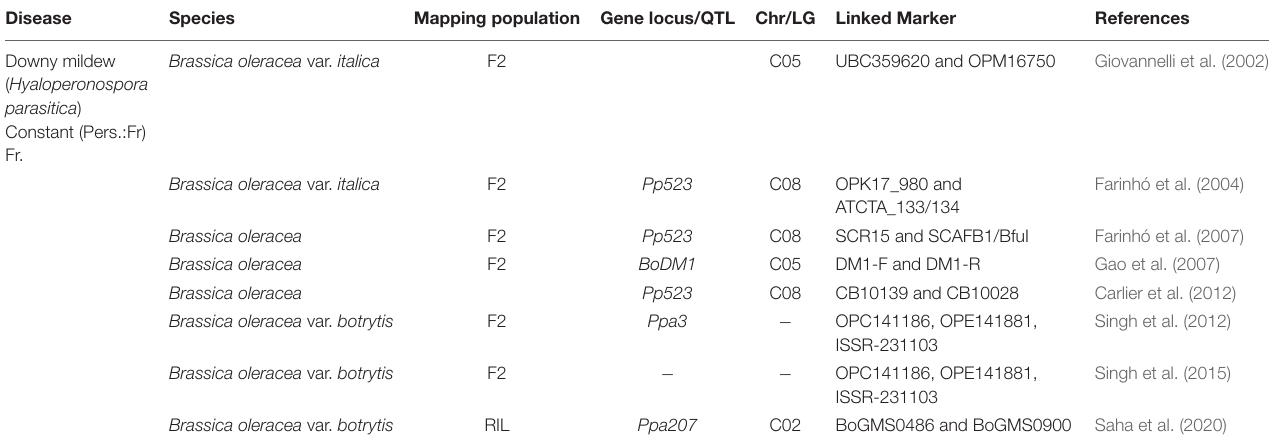
TABLE 1 | List of genes/QTLs associated with Downy mildew resistance in Brassica oleracea L. Disease Species Mapping population Gene locus/QTL Chr/LG Linked